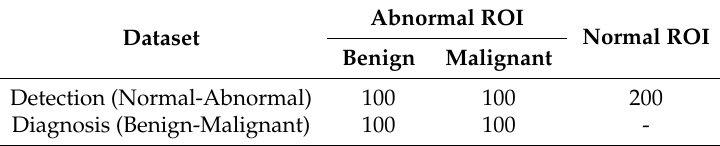
Table 1. The used ROI datasets for proposed method assessment.